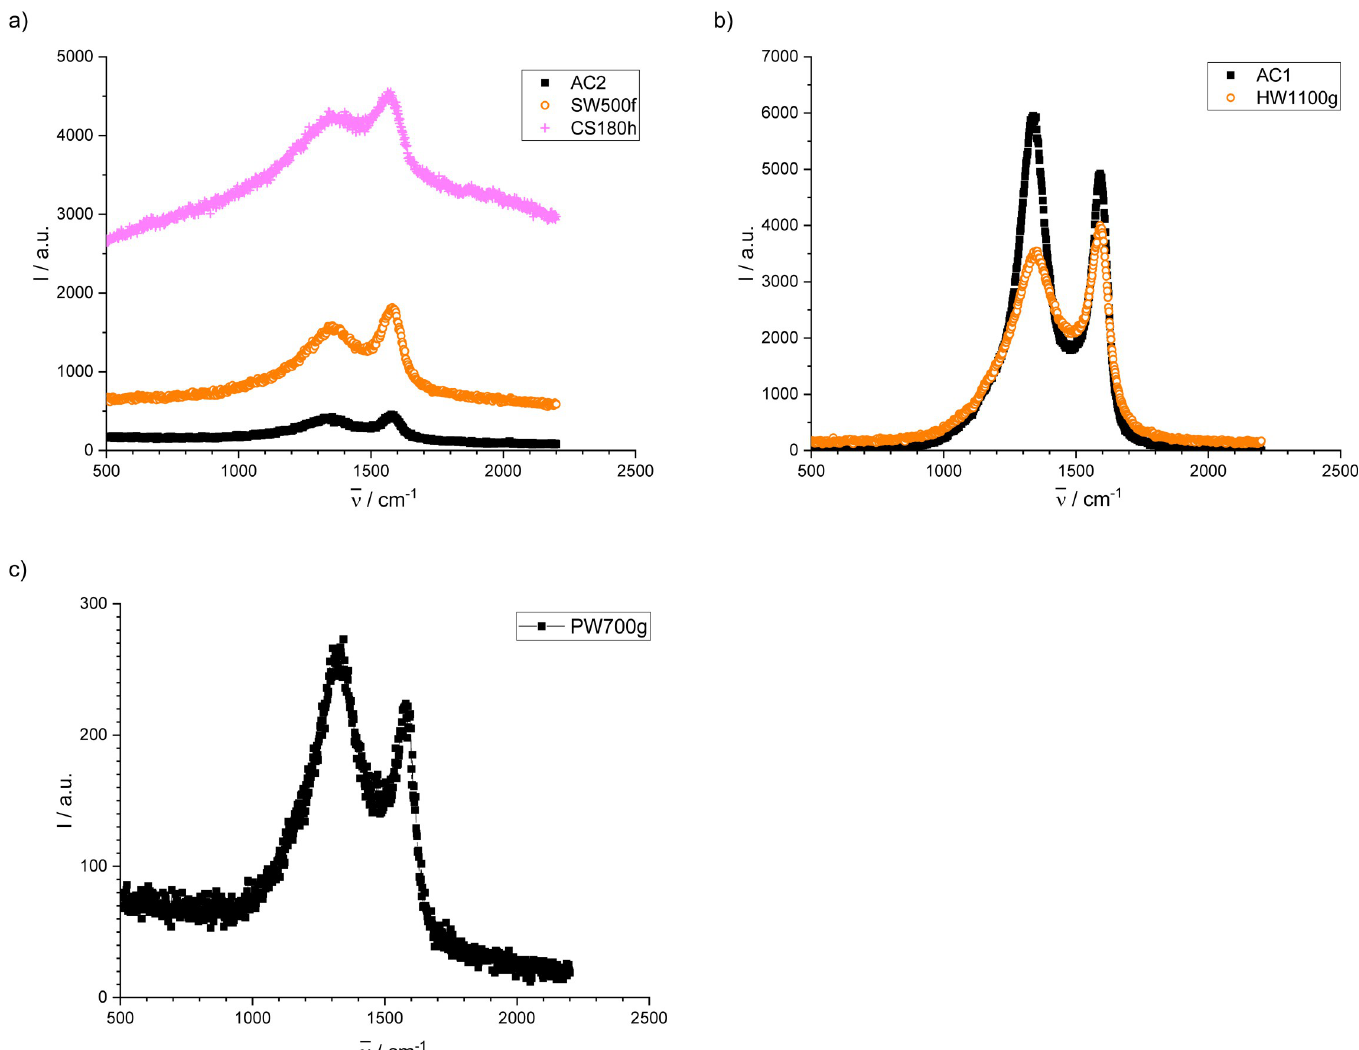
Fig 9. Raman spectra of biochars; a) AC2, SW500f, CS180h; b) AC1, HW1100g; c) PW700g.